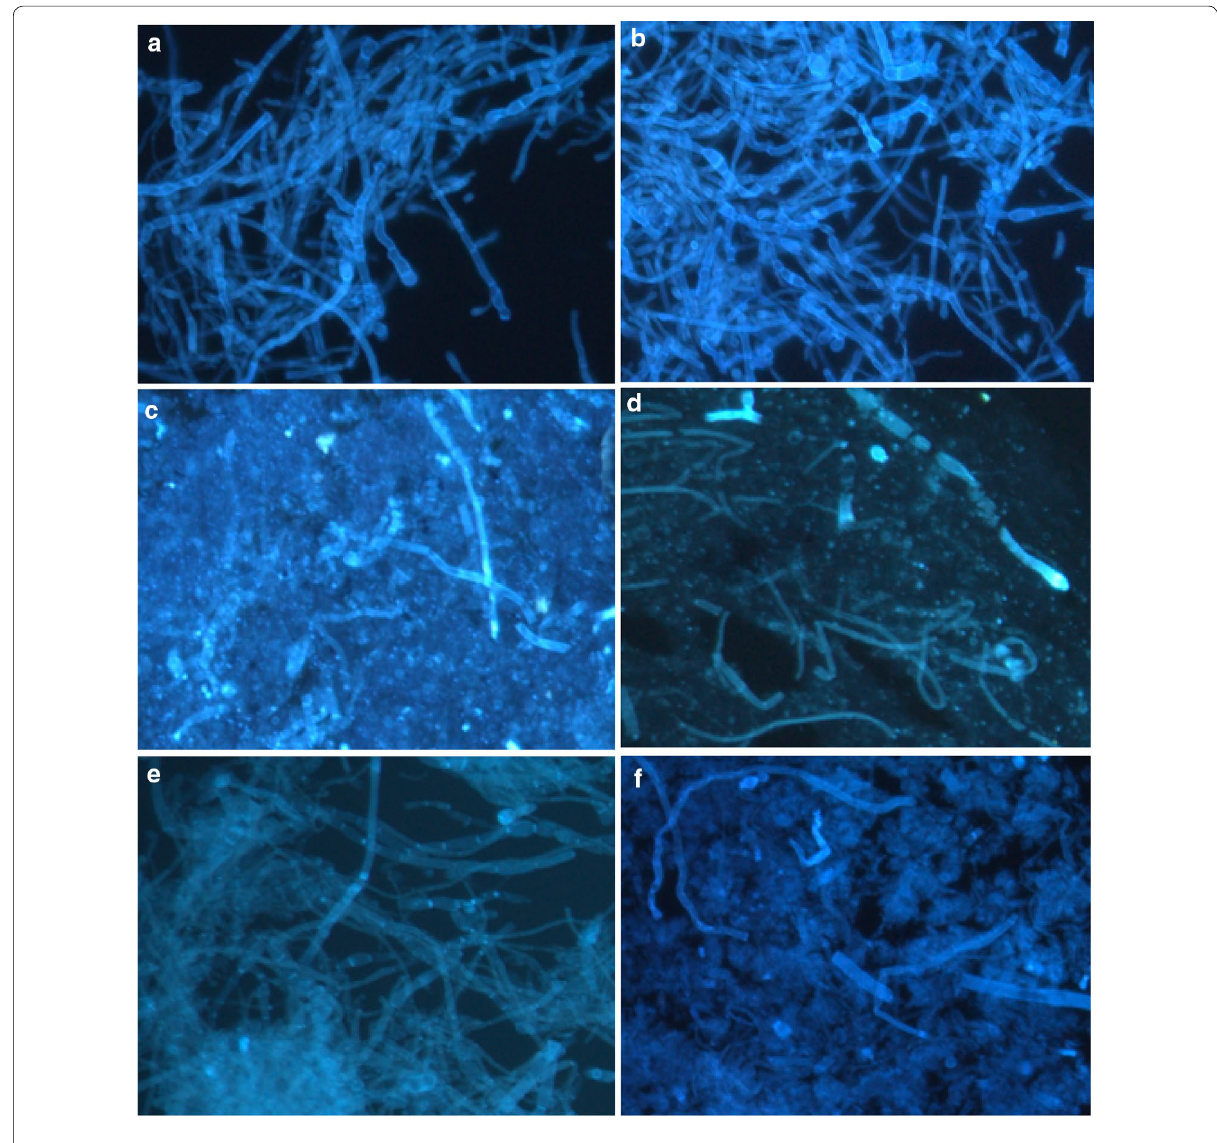
Fig. 4 Fluorescence photomicrographs of the freeze-dried dead biomass of F. oxysporum f. sp. spinaciae strain M2-1 incubated under the anaerobic conditions in the PY broth. a At the start of incubation; b after the anaerobic incubation of the pathogen biomass alone for 21 days; c , d incubated with strain H110 for 4 days ( c ) and 7 days ( d ); e , f incubated with strain TB8 for 7 days ( e ) and 14 days ( f ). Bar, 30